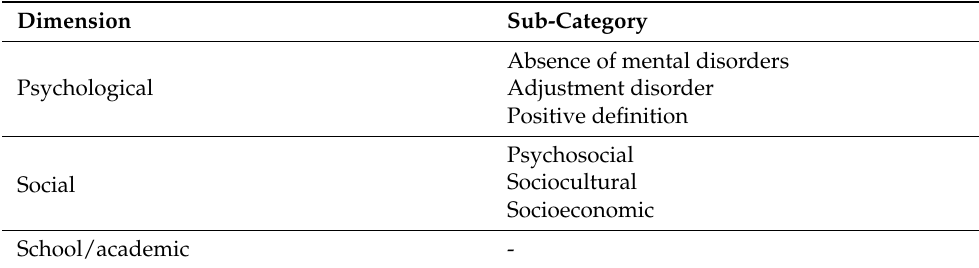
Table 2. Adjustment dimensions.